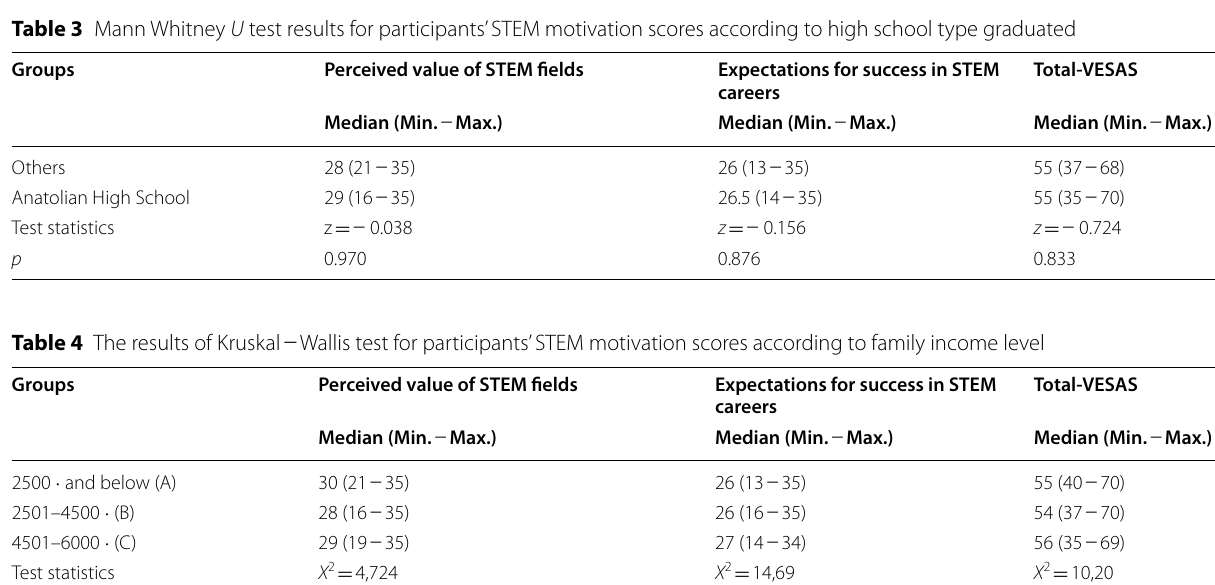
Significant difference C >